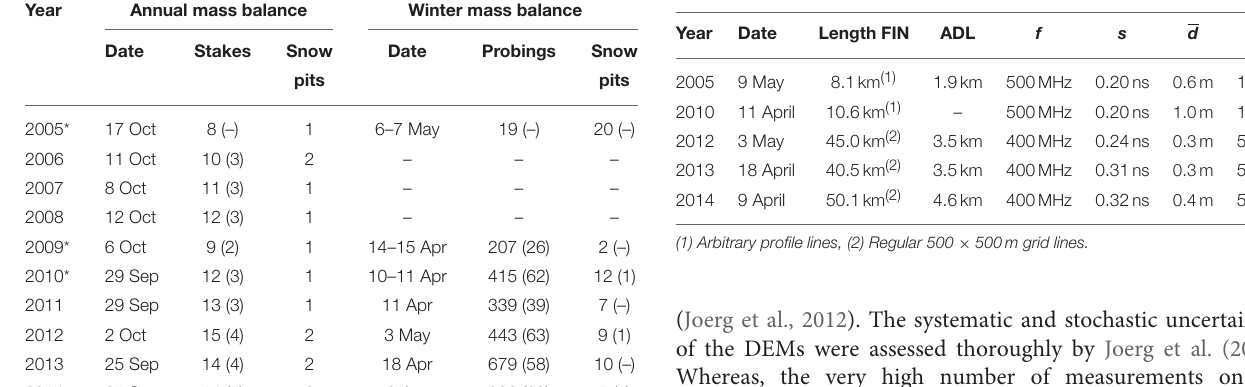
TABLE 2 | Date, length, signal frequency ( f ), sampling rate ( s ), average trace spacing ( d ), and number of measured traces per second ( t ) of the GPR measurements of snow accumulation distribution on Findelengletscher (FIN) and Adlergletscher (ADL).